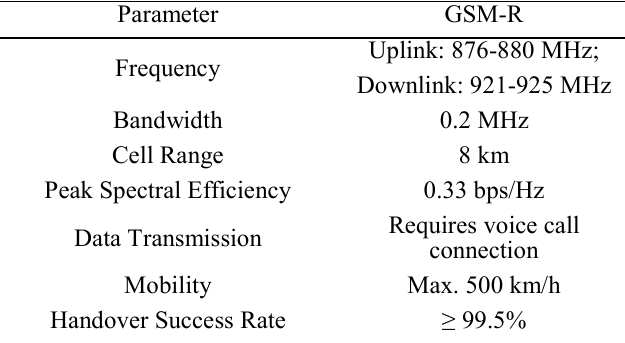
Table 1 . Performance of GSM-R system [8]